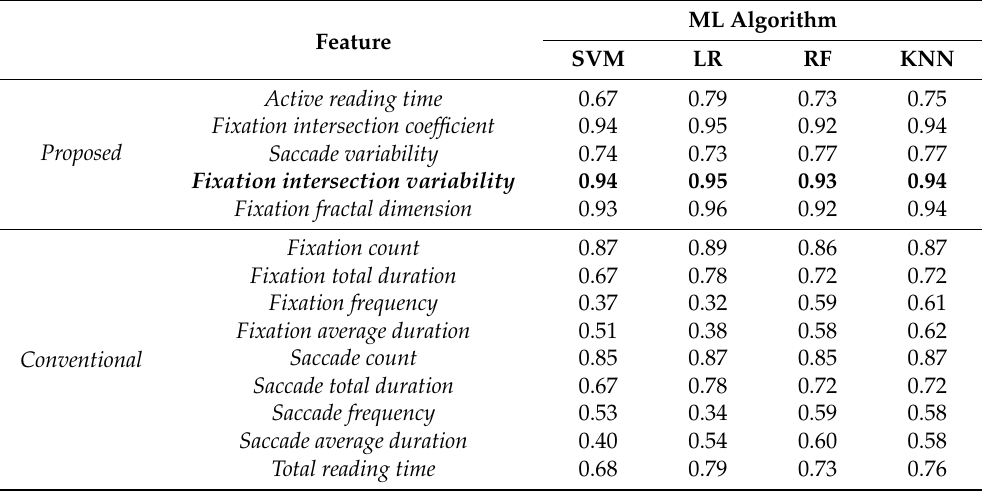
Table A4. Area under the receiver operating characteristic curve for single feature